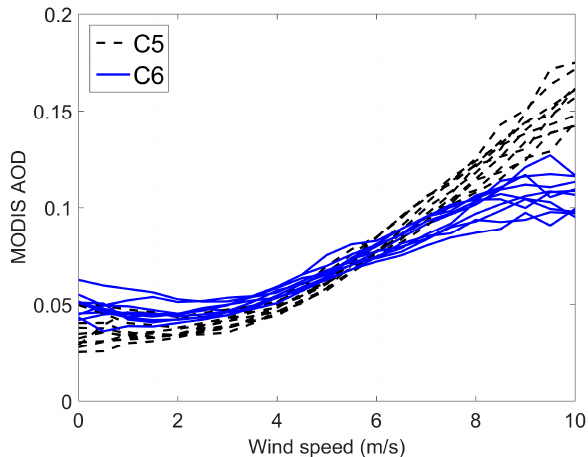
Figure 11. MODIS C5 and C6 AOD (black dashed and blue solid lines, respectively) versus surface wind speed, averaged with respect to September, October and November for the years